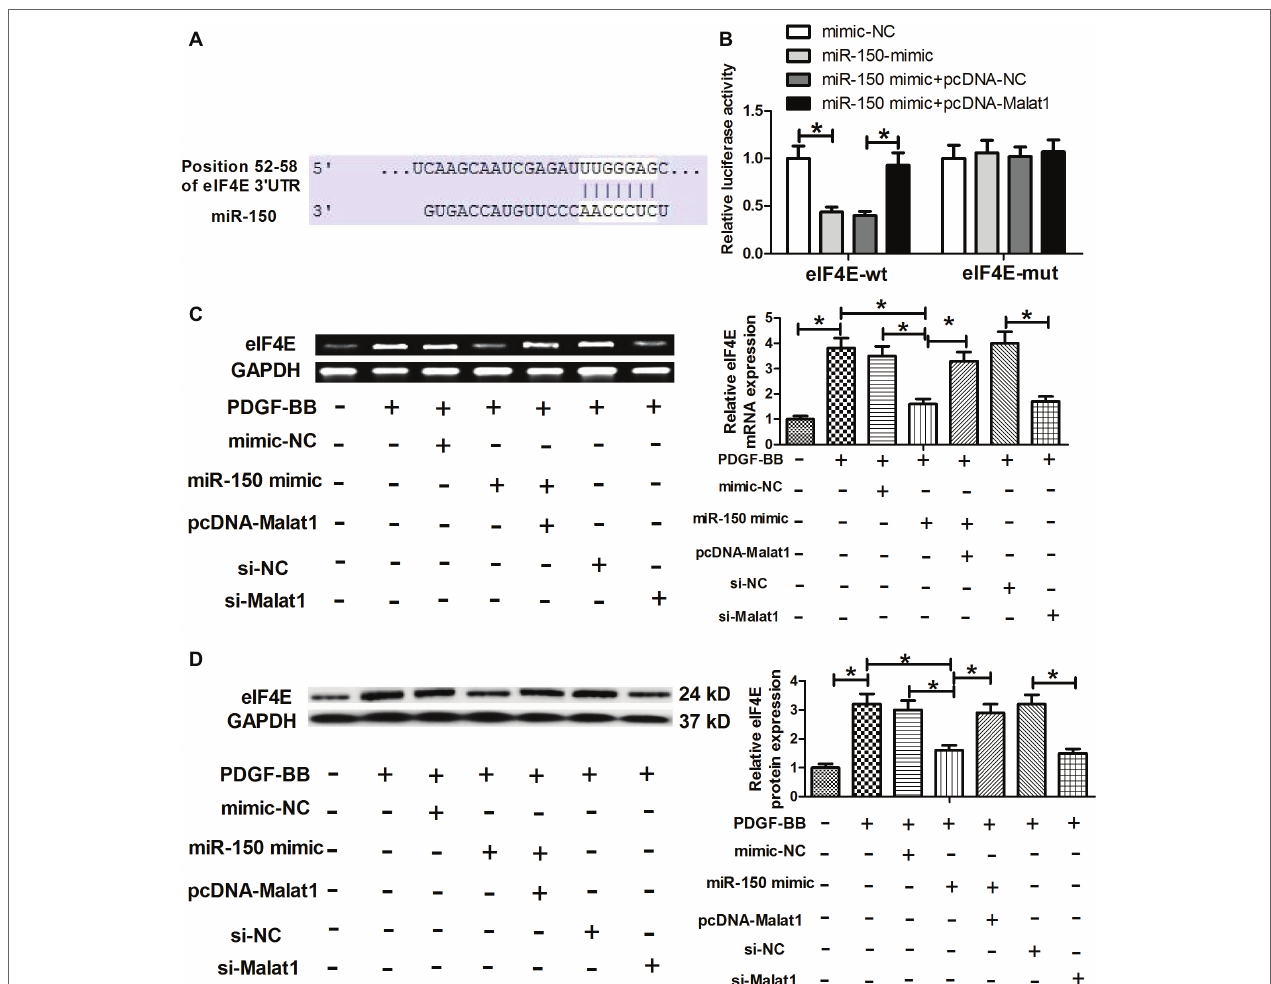
FIGURE 4 | eIF4E is a direct target of Malat1/miR-150 signal axis. (A) Diagram of the miR-150 putative binding sites in eIF4E 3 ′ -UTR. (B) Luciferase reporter assays show that miR-150 mimic transfection significantly reduces the luciferase activity of the reporter vector containing eIF4E-wt compared with mimic-NC transfection, whereas cotransfection with pcDNA-Malat1 and miR-150 mimic significantly relieves the inhibitory effect of miR-150 mimic transfection on luciferase activity. (C,D) eIF4E mRNA and protein expression in PDGF-BB-treated ASMCs transfected with mimic-NC, miR-150 mimic, miR-150 mimic + pcDNA-Malat1, si-NC, or si-Malat1 determined by RT-PCR and western blot, respectively. * p <